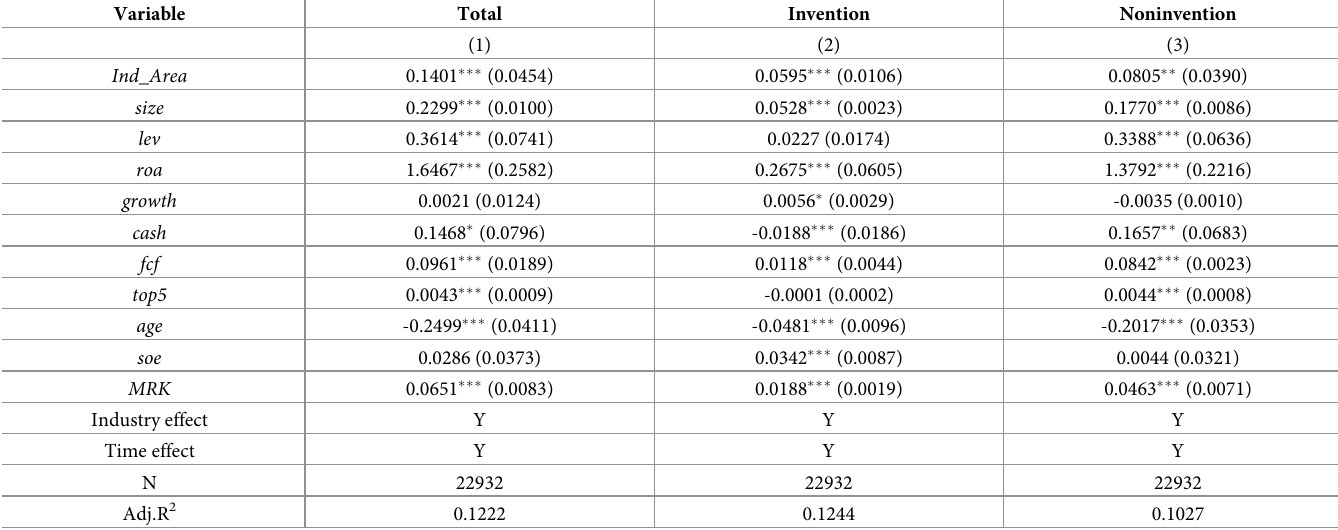
Table 10. Number of patent applications as the explained variable. Variable